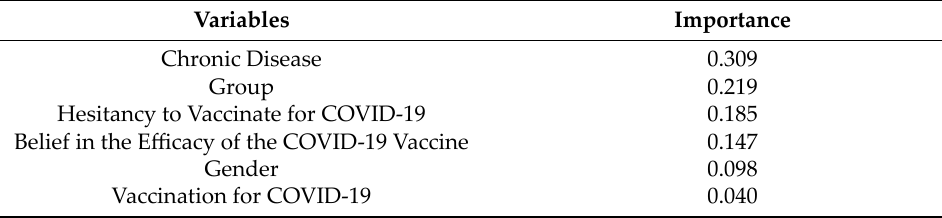
Table 9. Variable importance values obtained from the MLP model for